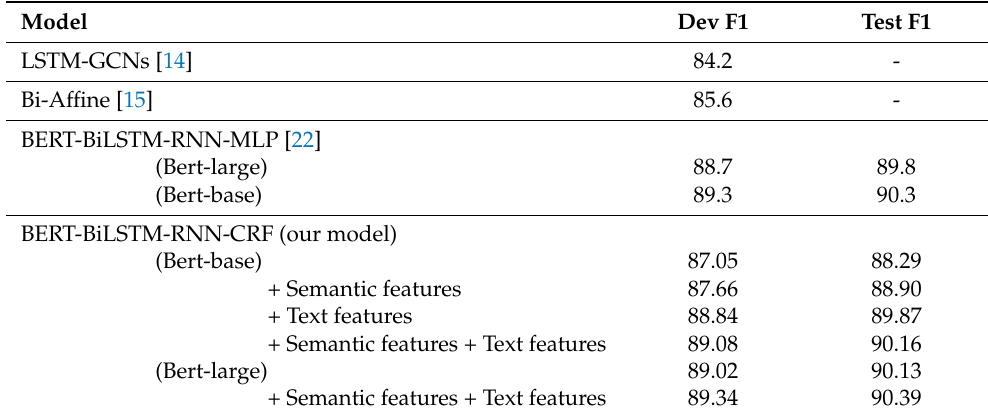
Table 2. F1 on the CoNLL-2009 English benchmark with gold